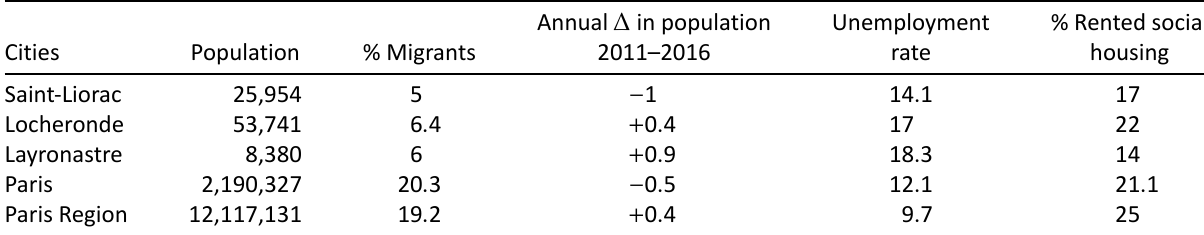
Table 1. Socio-demographic data of sites researched.